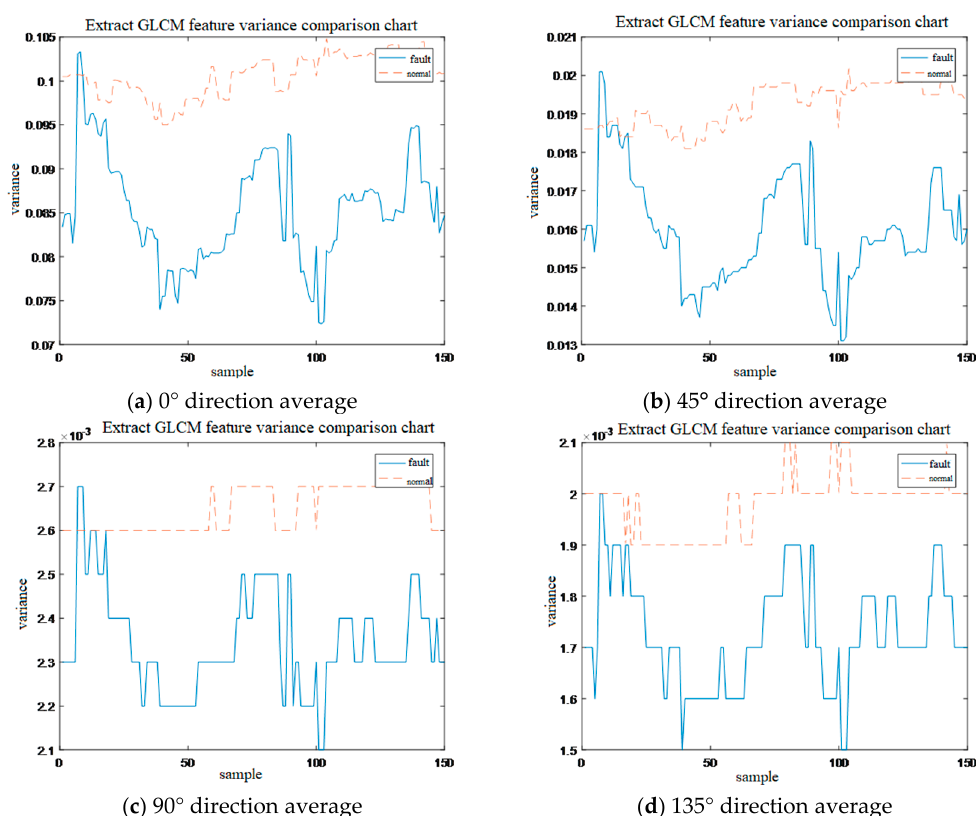
Figure 5. GLCM feature average value comparison.